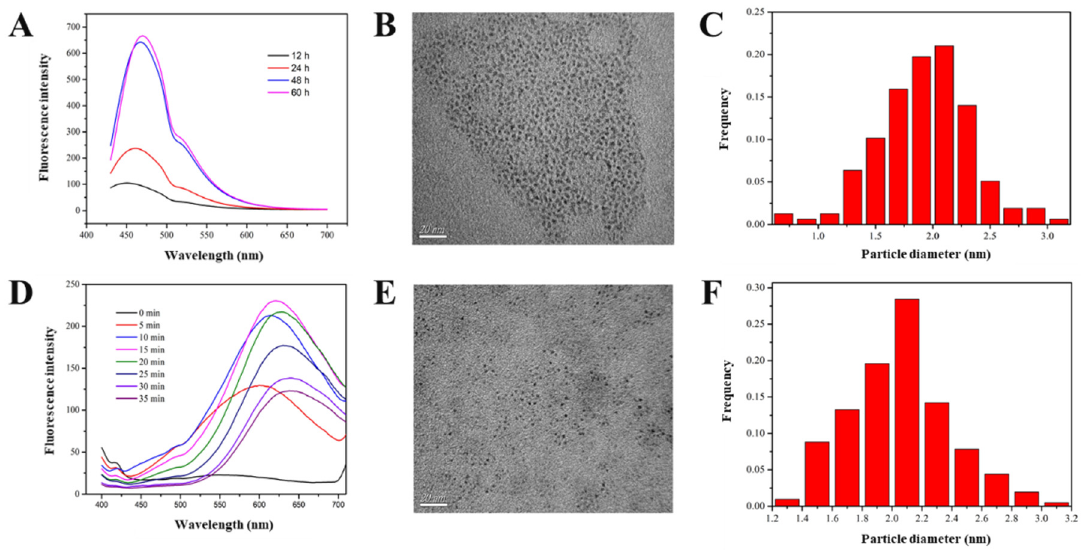
Figure 1. ( A ) The fluorescent spectrum of SiQD with different synthesis time. ( B ) TEM of SiQD (scale bar 20 nm). ( C ) Size distribution of SiQD. ( D )The fl uorescent spectrum of AgNC with di ff erent syn- thesis time. ( E ) TEM of AgNC (scale bar 20 nm). ( F ) Size distribution of AgNC.